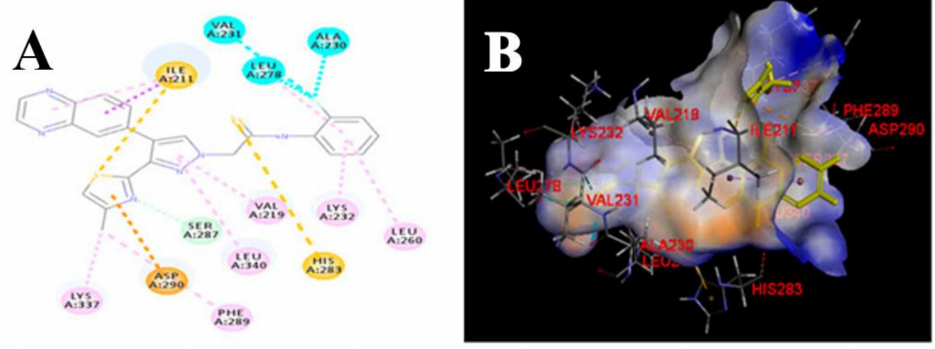
Figure 87. Docking pose of compound 79 in the active site of ALK5. ( A ) 2D binding interactions pro; ( B ) Proposed pose of 79 in the binding pocket of ALK5. The ligands are shown in yellow